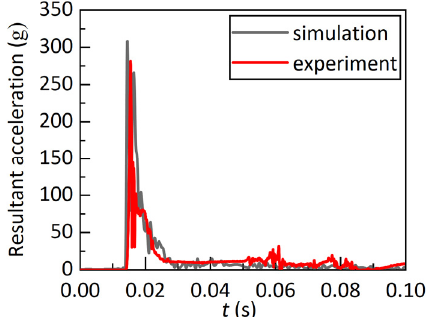
Figure 3. Head–ground impact experiment. Figure 4. Setup of head-ground impact FE model. Black solid line is the parallel line of the vertical plane, and red solid line is that of the brain sagittal plane after rotating 8°. Red dotted line is located in the coronal plane of the head. The size of the ground is 500 × 500 × 60 mm. Figure 5. Comparison of skull fracture patterns between the ( A ) experiment and ( B ) simulation. Figure 5. Comparison of skull fracture patterns Figure 6. Comparison of head resultant acceleration between the ( A ) experiment and ( B ) simulation. between the experiment and simulation.